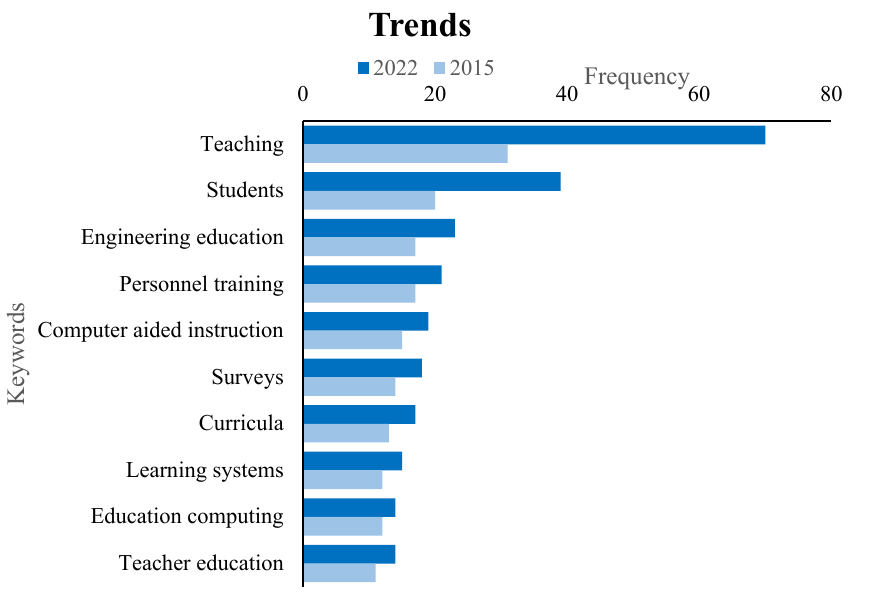
Figure 8. Keywords most used in research on the topic. Own elaboration from SCOPUS data.